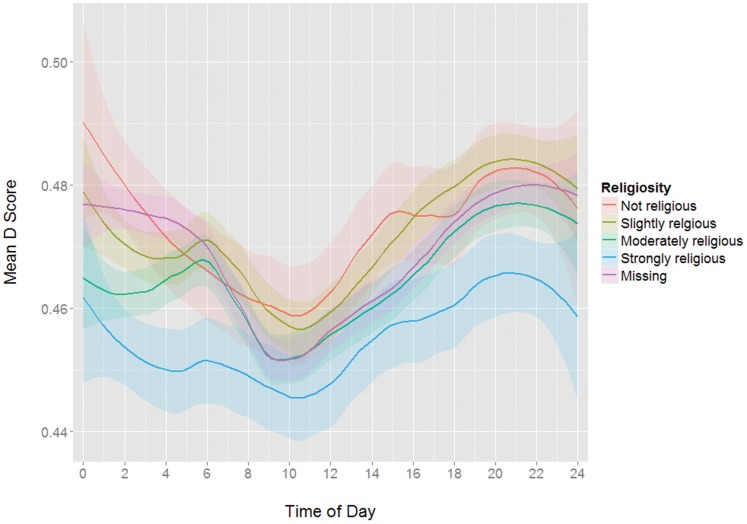
Mean D scores by time of day grouped by religiosity.